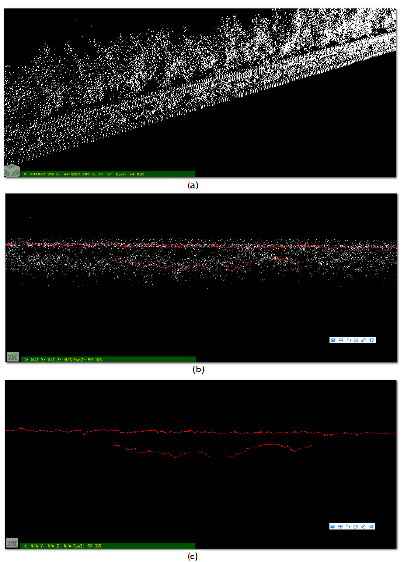
Figure 2.Isolation belt in the middle of road.